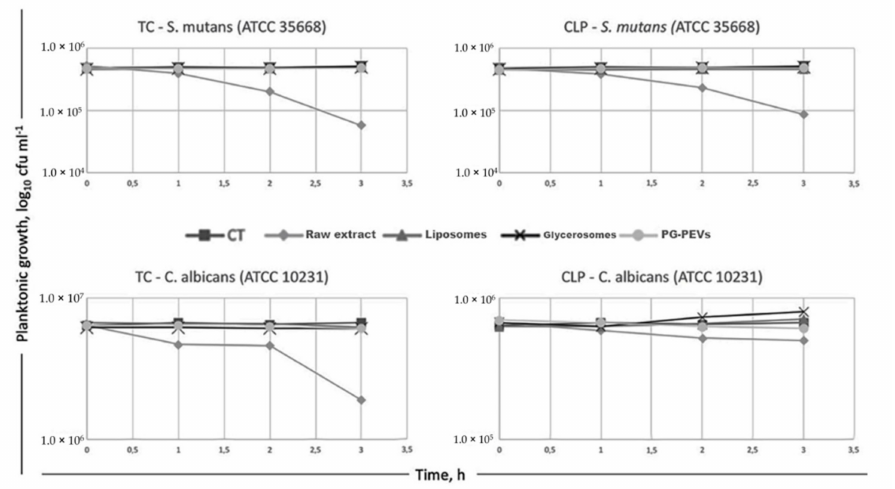
Figure 3. Time-kill curves of S. mutans and C. albicans treated with TC essential oil, CLP extract, and their nanovesicles.